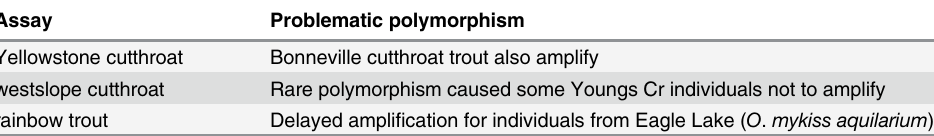
Table 3. Summary of results of the validated taxon-specific qPCR assays.